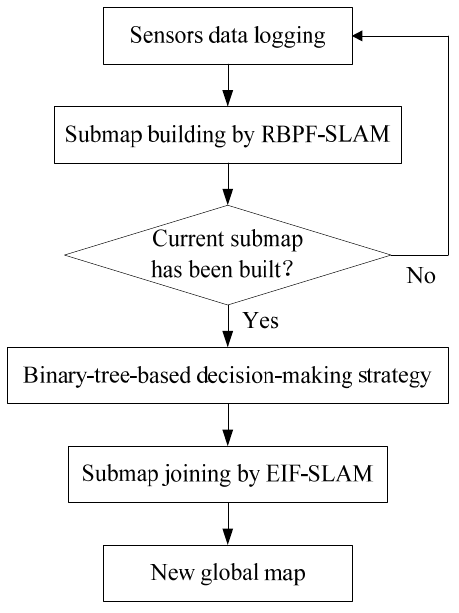
Figure 1. The overall structure of the Combined SLAM